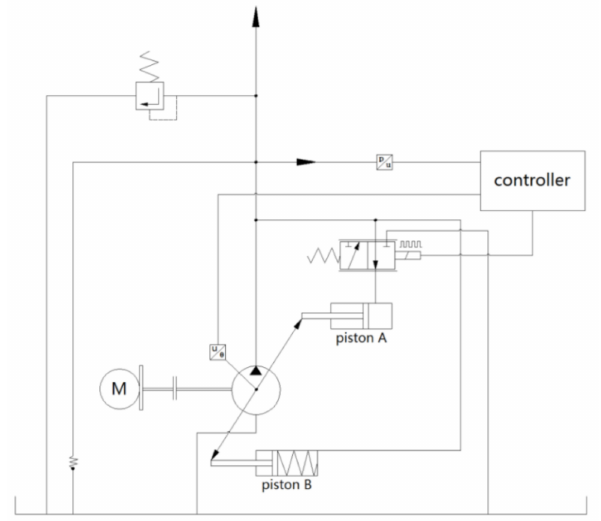
Figure 28. High-speed switching valve controlled variable axial piston